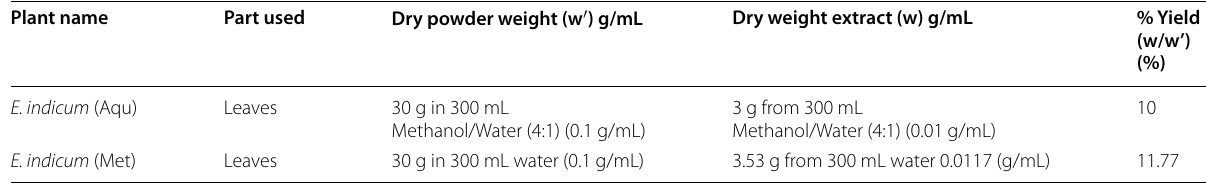
Table 1 Extractive yield (%) obtained from the methanol and aqueous extracts of the leaves of E. indicum Plant